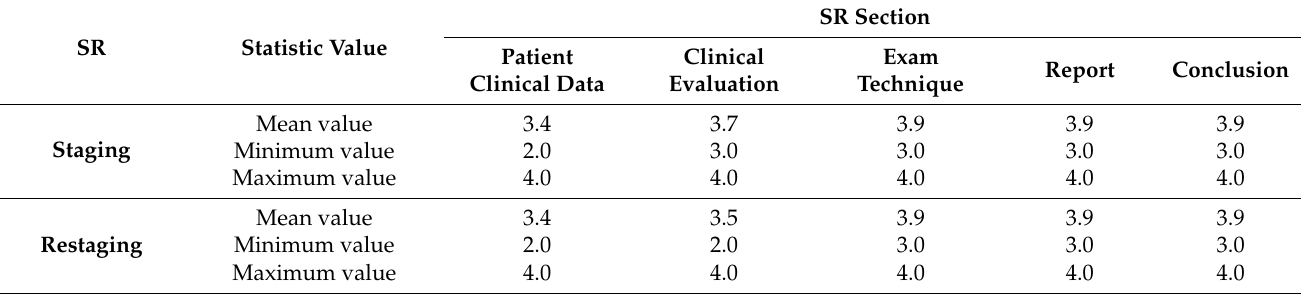
Table 2. Mean and range values of scores for RC staging and restaging reports (second round).